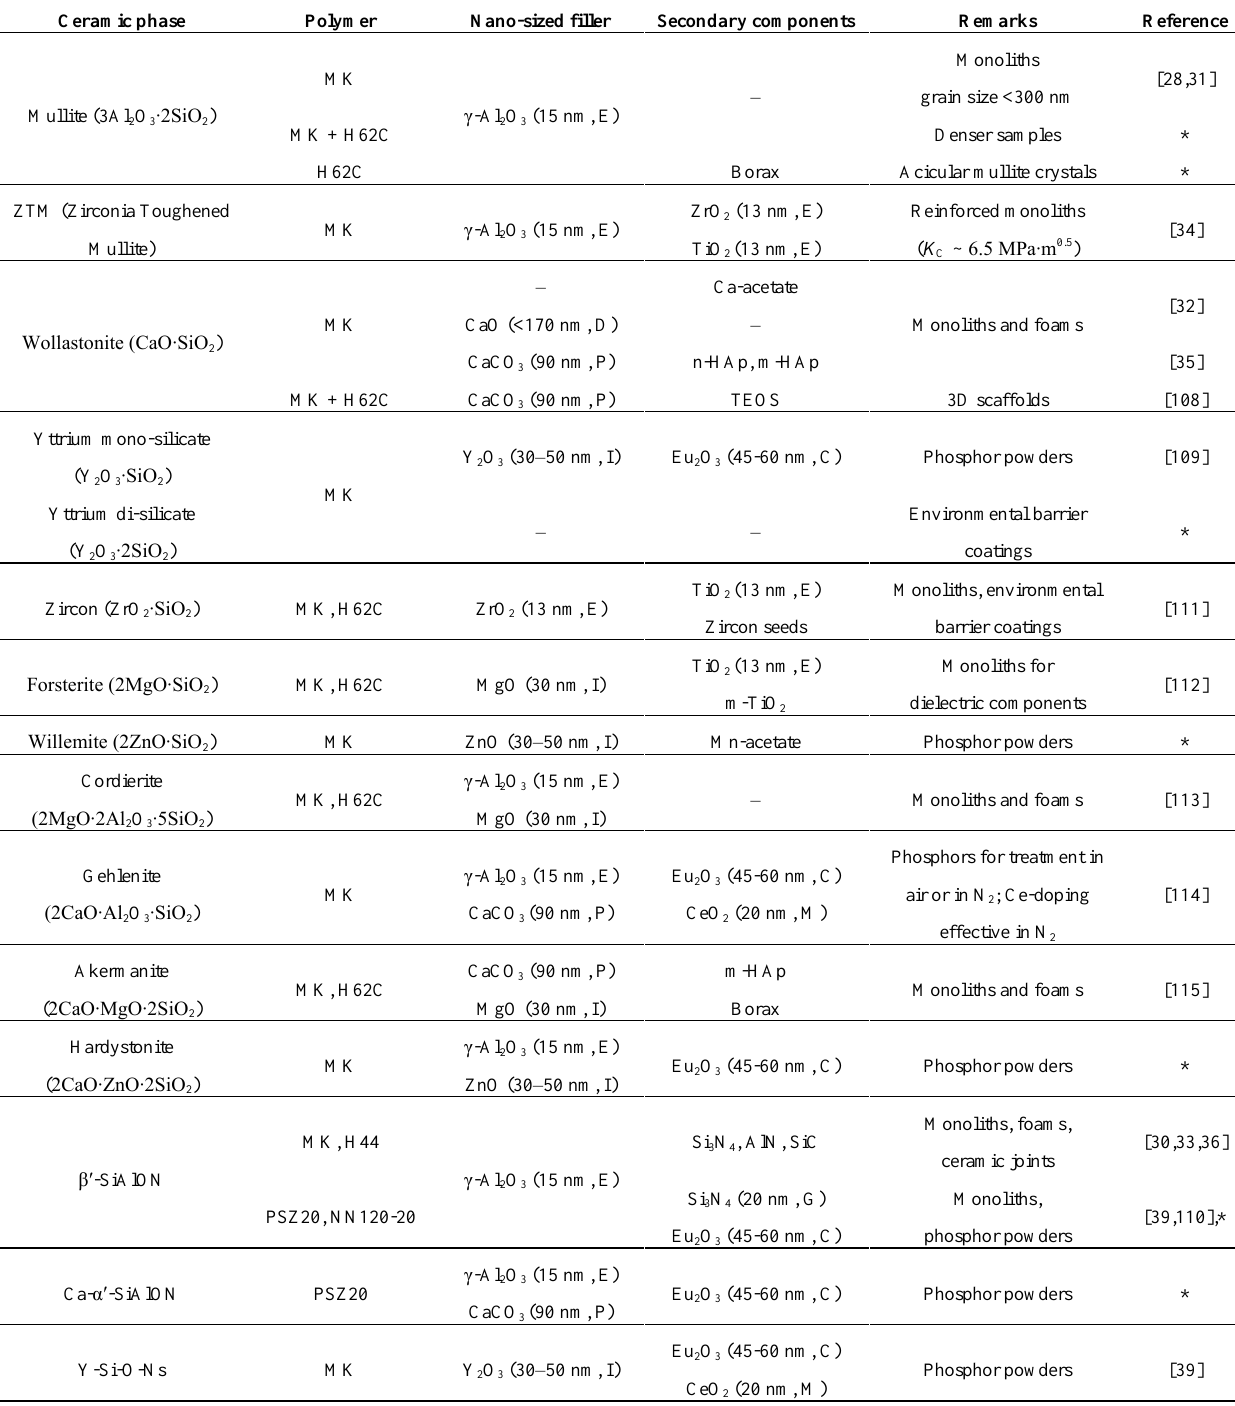
Table 1. Summary of silicate and oxynitride ceramics from preceramic polymers and nano-sized fillers prepared at the University of Padova (* not previously